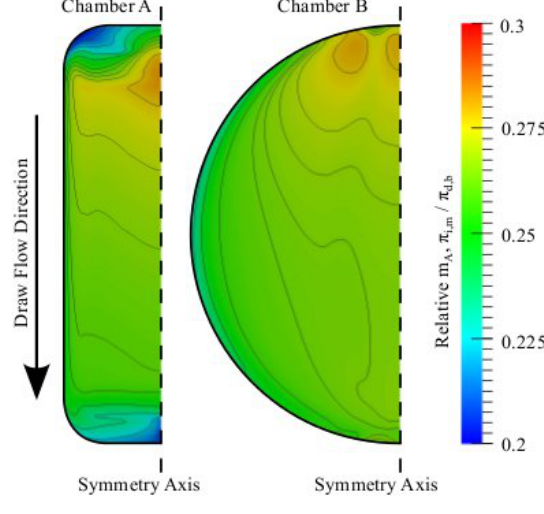
Figure 6. ICP maps showing the concentration at the interface between the porous support and the active separation layer of the composite membrane relative to the bulk concentration of solute in the draw. The inlets of both chambers are at the top of the figure, and correspondingly the outlets are at the bottom. Both simulations were performed with 1 M draw solutions, pure water feed solutions and a 50 mL min − 1 cross-flow. Contour lines are shown for arbitrary scalars to guide the eye.